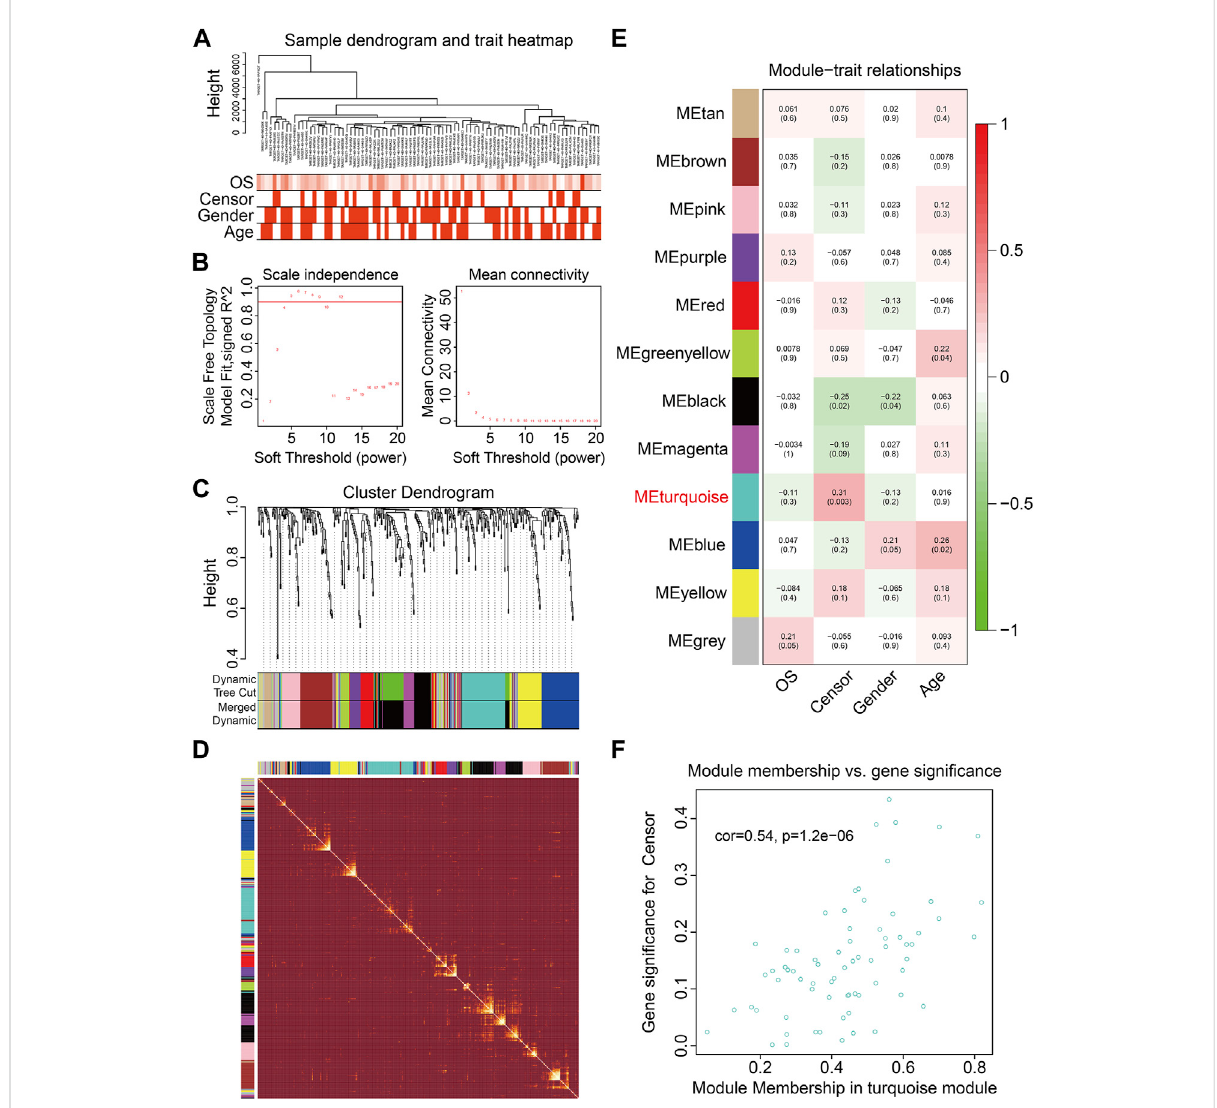
FIGURE 2 Weighted gene coexpression network analysis of the differentially expressed genes induced by RSL3. (A) Cluster analysis between the FAGs in TCGA osteosarcoma dataset and clinical traits. (B) Screening and validation of the soft threshold. (C) Cluster dendrogram indicating diverse FAG modules. (D) Correlationheatmapofgenesindifferentmodules. (E) Correlationanalysisbetweengenemodulesandclinicalfeaturessuchasgender, age, censor, and overall survival (OS) time. (F) Scatter plot shows the module membership between the turquoise module and clinical feature vital